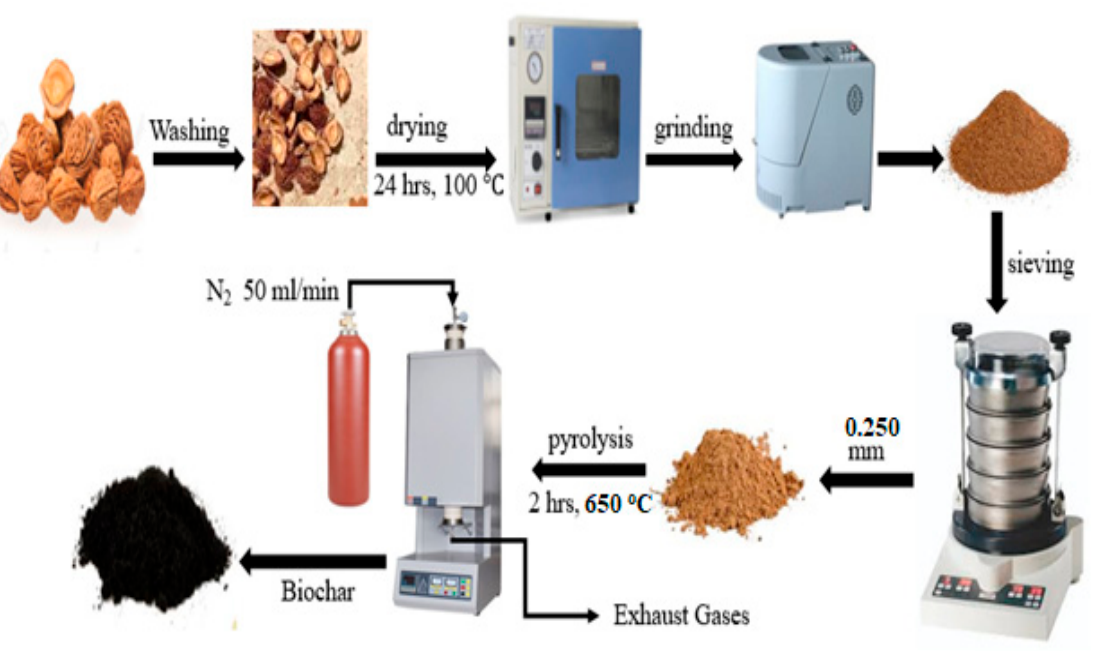
Figure 14. Schematic diagram of biochar preparation.